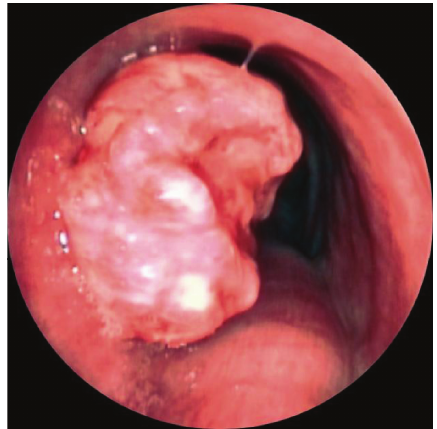
Figure 4: Snapshot by tracheoscopy during the surgery shows an obstructive and fleshy tracheal mass.